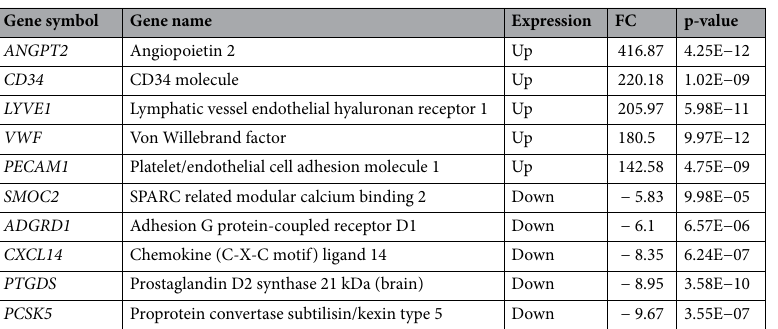
Table 3. Top five upregulated and downregulated genes due to the presence of BVs (NHMO vs. NMO).